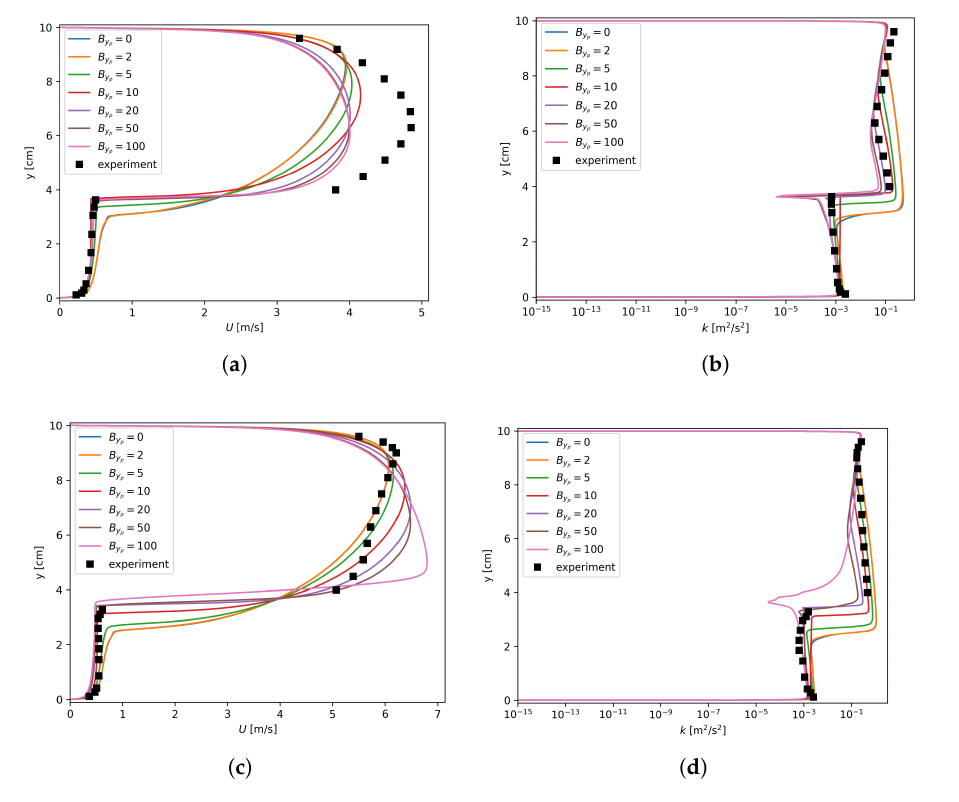
µ 2 g with δ = − ρ l . ( a ) Run 250; ( b ) Run 400; ( c ) Run 600. ρ g p µ 2 l